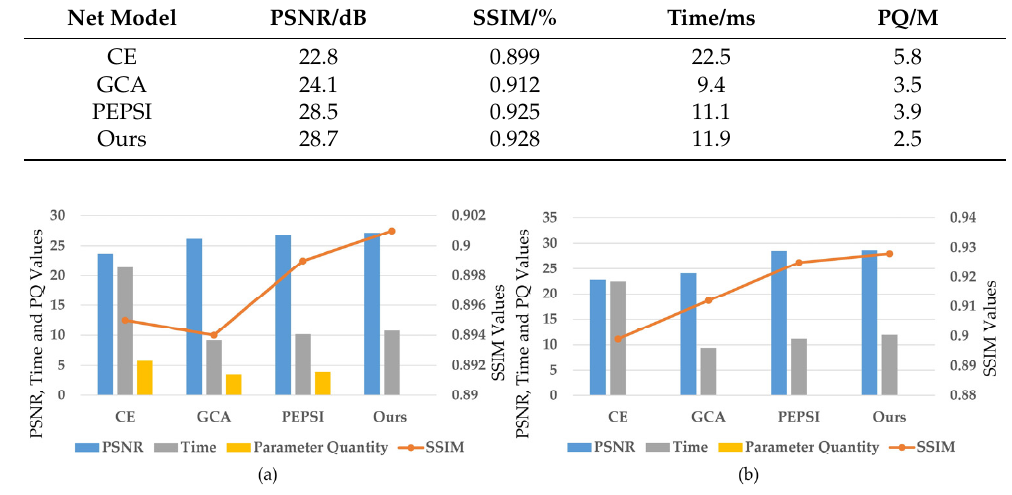
Figure 13. Bar charts of performance for different inpainting methods. ( a ) Metric values on square mask. ( b ) Metric values on free mask.